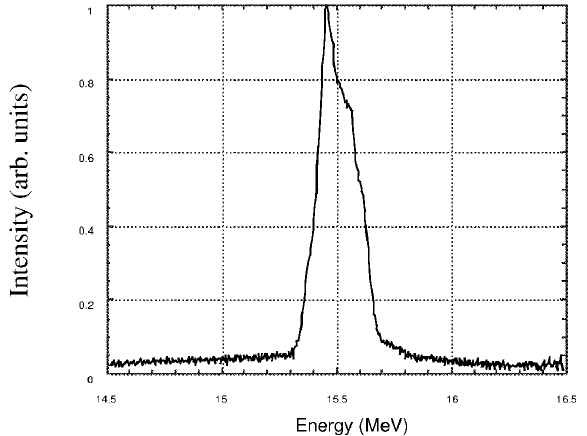
FIG. 9. Energy spectrum of low charge pulse train ( 4 3 (cid:6) 0.5 nC) with an average energy of E energy spread is observed to be much less than in the high charge